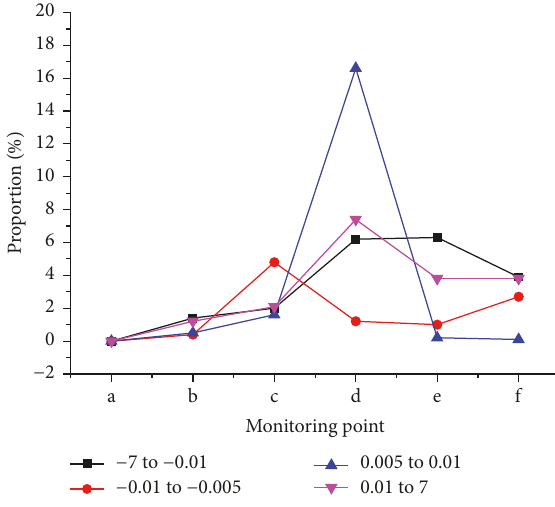
Figure 14: Change in the quantitative proportions of different rotation angles over time.